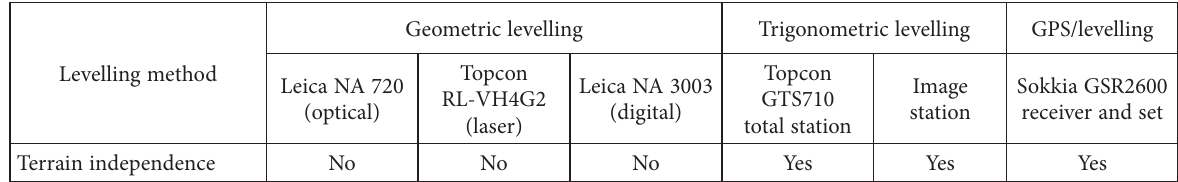
Table 8. Terrain independence for each levelling